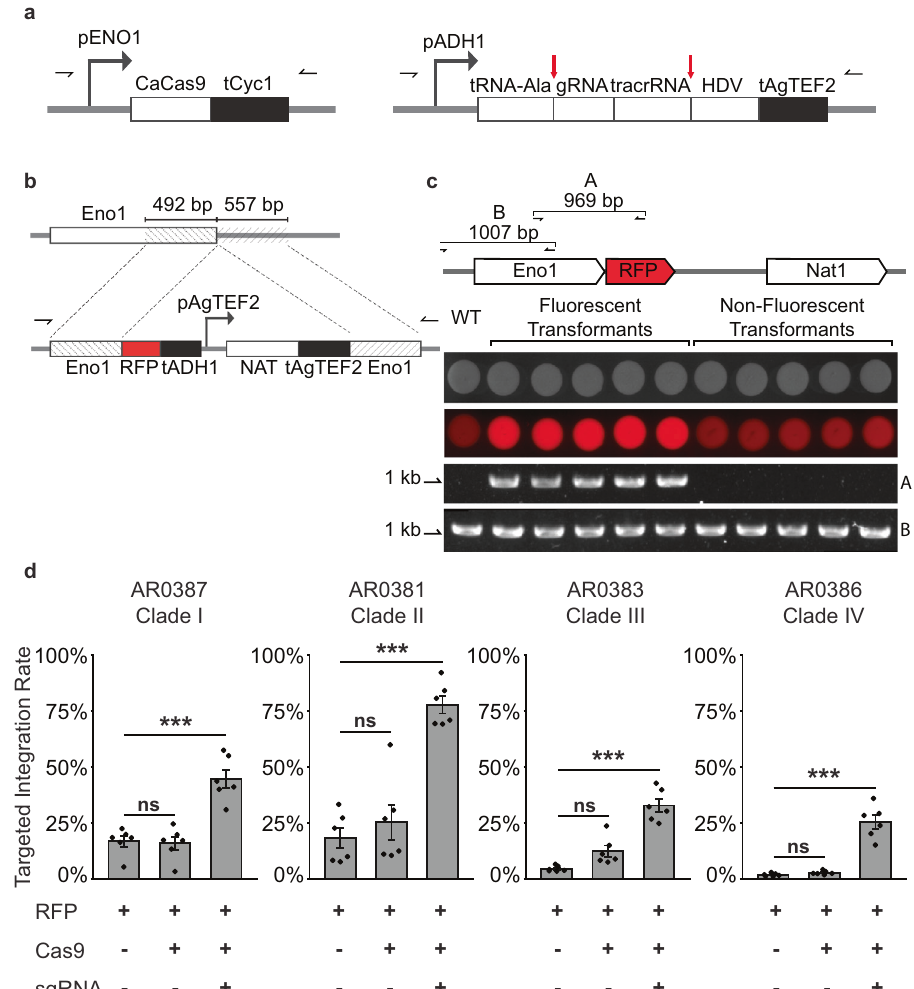
Fig. 3 A CRISPR-Cas9 expression system promotes targeted transformation in four C. auris clades. a Structures of the Cas9 and sgRNA expression cassettes. CAS9 is driven by the C. auris ENO1 promoter and followed by the CYC1 terminator. The sgRNA cassette is driven by the C. auris ADH1 promoter and contains C. auris tRNA-Ala immediately upstream of the 20-bp gRNA sequence and hepatitis delta virus (HDV) ribozyme immediately downstream of the tracrRNA sequence. Predicted post-transcriptional cleavage sites are indicated by red vertical arrows. Primer sites to generate linear transformation cassettes are indicated by horizontal arrows. b Design of the reporter cassette for measuring targeted integration. The cassette is fl anked by approximately 500-bp homology to the C. auris ENO1 C-terminus minus the stop codon and the region immediately downstream of C. auris ENO1 . RFP and the C. auris ADH1 terminator tag the ENO1 gene at the C-terminus via a glycine linker to generate ENO1-RFP in targeted transformants. An independently driven nourseothricin resistance cassette (NAT) allows identi fi cation of total transformants, regardless of integration site, by selection with nourseothricin. c Targeted integration events are identi fi able by colony fl uorescence. Transformation of AR0387 was performed using the reporter cassette described in panel ( b ). Representative fl uorescent transformants and non- fl uorescent transformants were spotted onto YPD. Primer set A, spanning the ENO1-RFP junction, shows ampli fi cation only from fl uorescent transformants. Primer set B, spanning a neighboring wild-type locus, shows ampli fi cation from all transformants and the wild type. d Expression of Cas9 and sgRNA promotes targeted integration rate. Transformation was performed in representative isolates from all four major C. auris clades with the linear transformation cassettes described in panels ( a ) and ( b ). Transformations were performed with and without Cas9 and sgRNA elements; when absent, the cassettes were replaced with an equivalent volume of buffer. Targeted integration rate is expressed as the ratio of fl uorescent colonies recovered to total nourseothricin-resistant colonies recovered. Each point represents an individual transformation. Shown are the mean ± standard error of the mean from three individual experiments, each performed in duplicate. Source data are provided as a Source Data fi le. Statistical differences were determined using one-way ANOVA with Tukey ’ s post hoc test for multiple comparisons: AR0387: *** p = 5.4 × 10 − 5 , ns: p = 0.98; AR0381: *** p = 5.8 × 10 − 6 , ns: p = 0.66; AR0383: *** p = 6.0 × 10 − 7 , ns: p = 0.063; AR0386: *** p = 3.0 × 10 − 7 , ns: p =